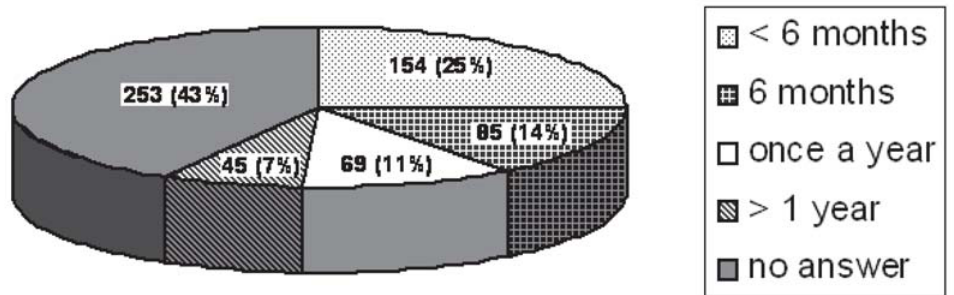
FIGURE 3- Frequency of the children’s visits to the dentist